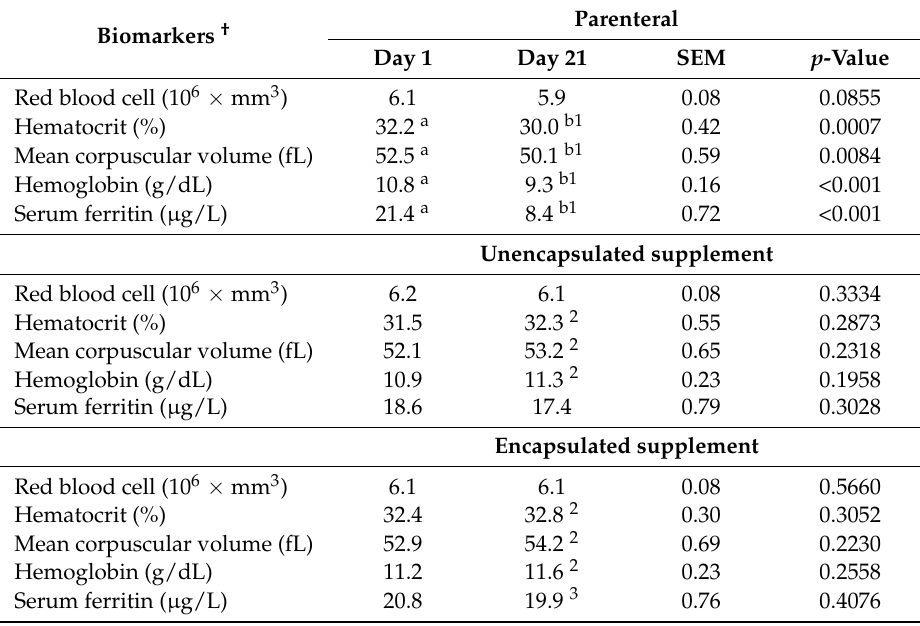
Table 2. Biomarkers for the iron nutrition status expressed as mean and standard error of mean (SEM) for piglets subjected to different iron supplementation